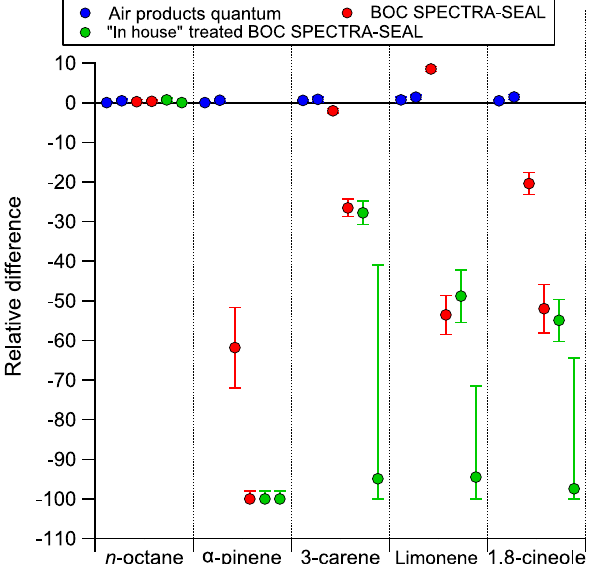
Figure 3. The relationship between cylinder pressure and monoter- pene amount fraction after normalisation to n